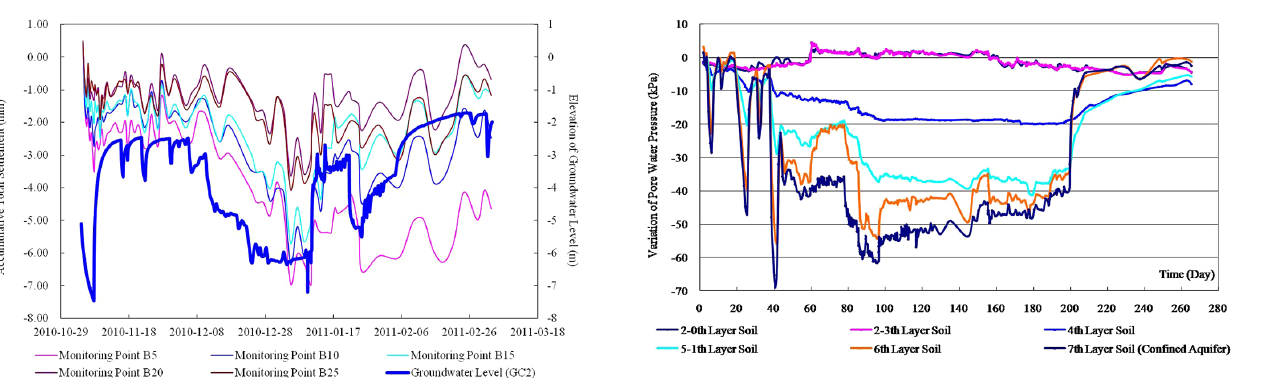
Figure 5. Duration graphical chart of land subsidence and artesian head in monitoring section.